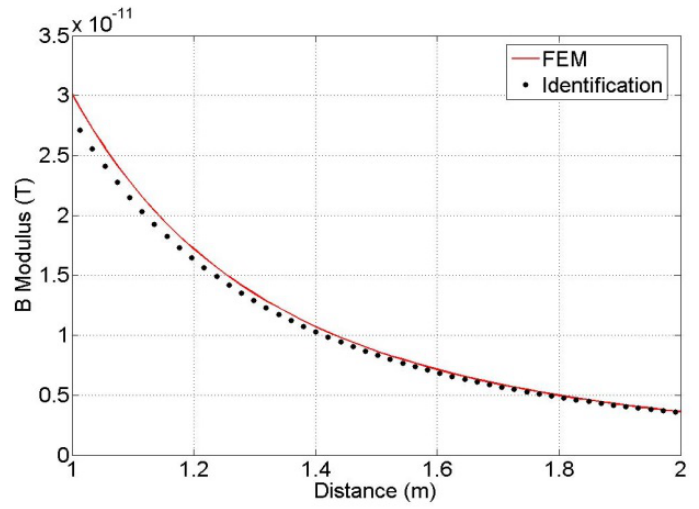
Figure 11. Magnetic field decrease (modulus) vs. the distance from the